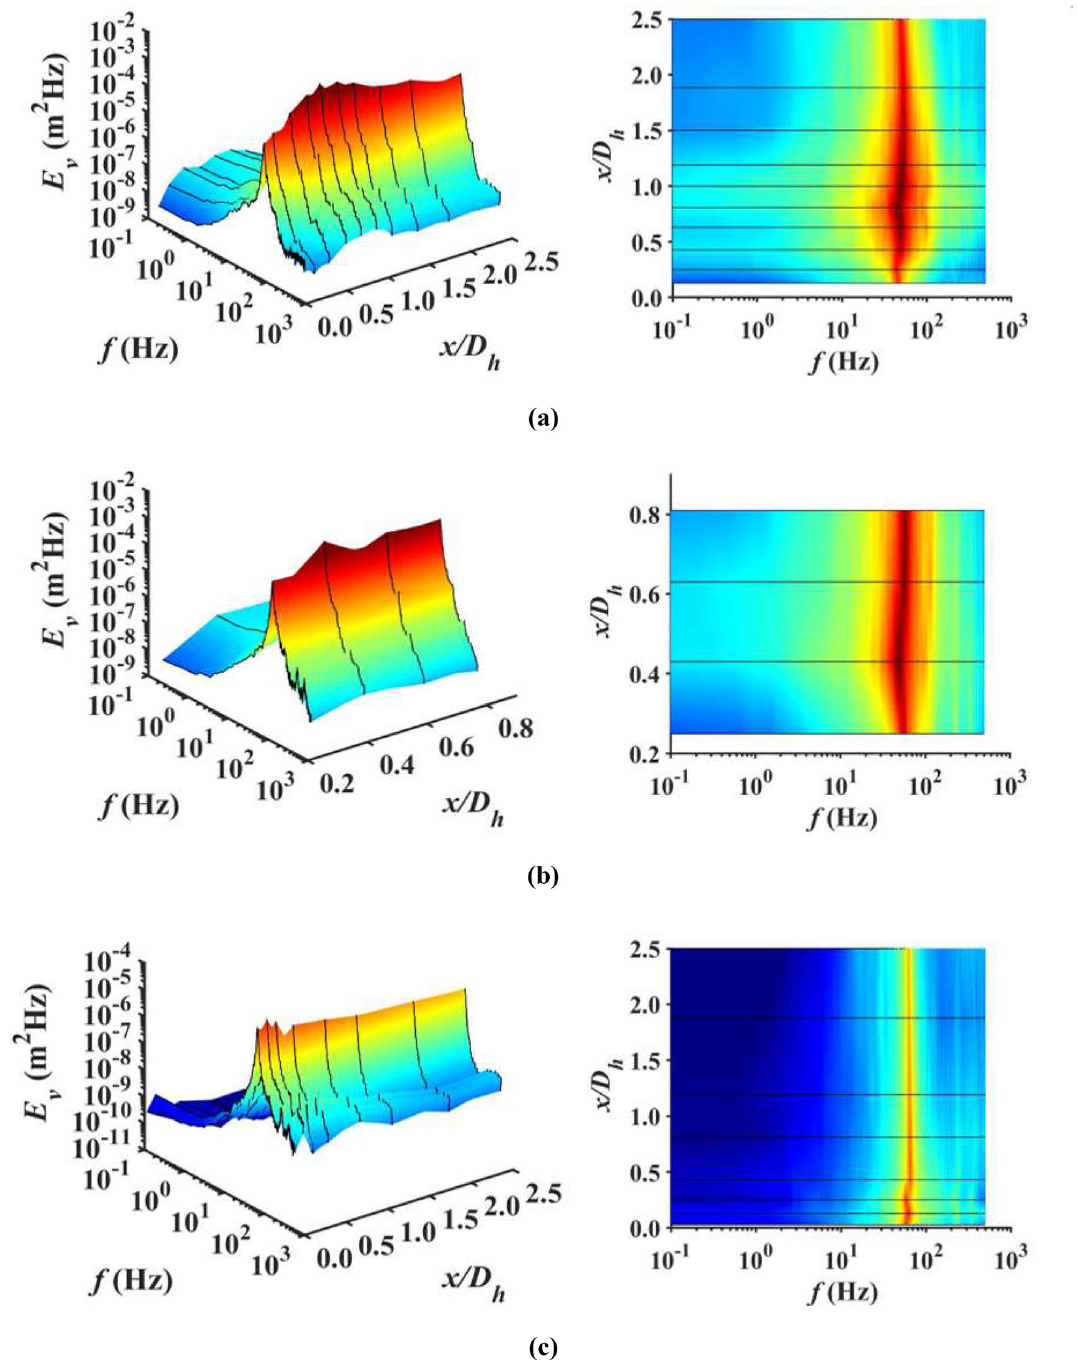
Figure 7. Downstream evolution of the energy spectrum (left) on ( a ) P 0 , ( b ) P 5 of SFG, and ( c ) centerline of RG; top view of the respective spectrum